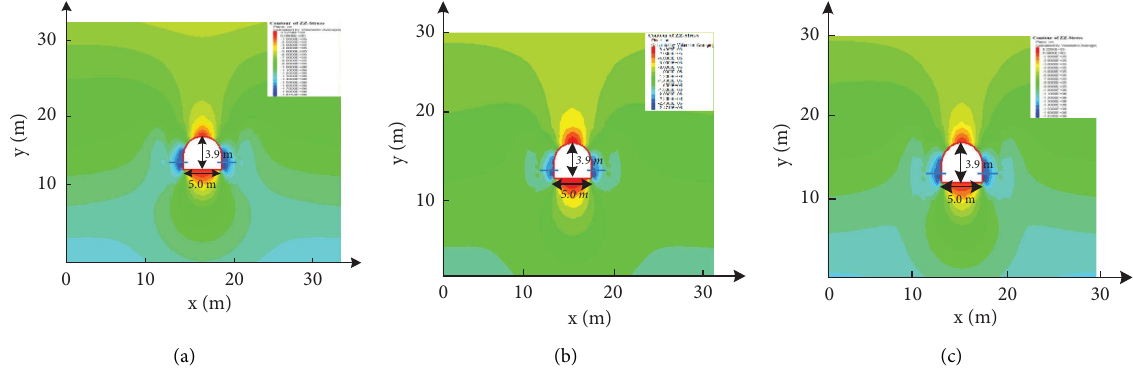
Figure 12: Vertical stress. (a) Scheme 1. (b) Scheme 2. (c) Scheme